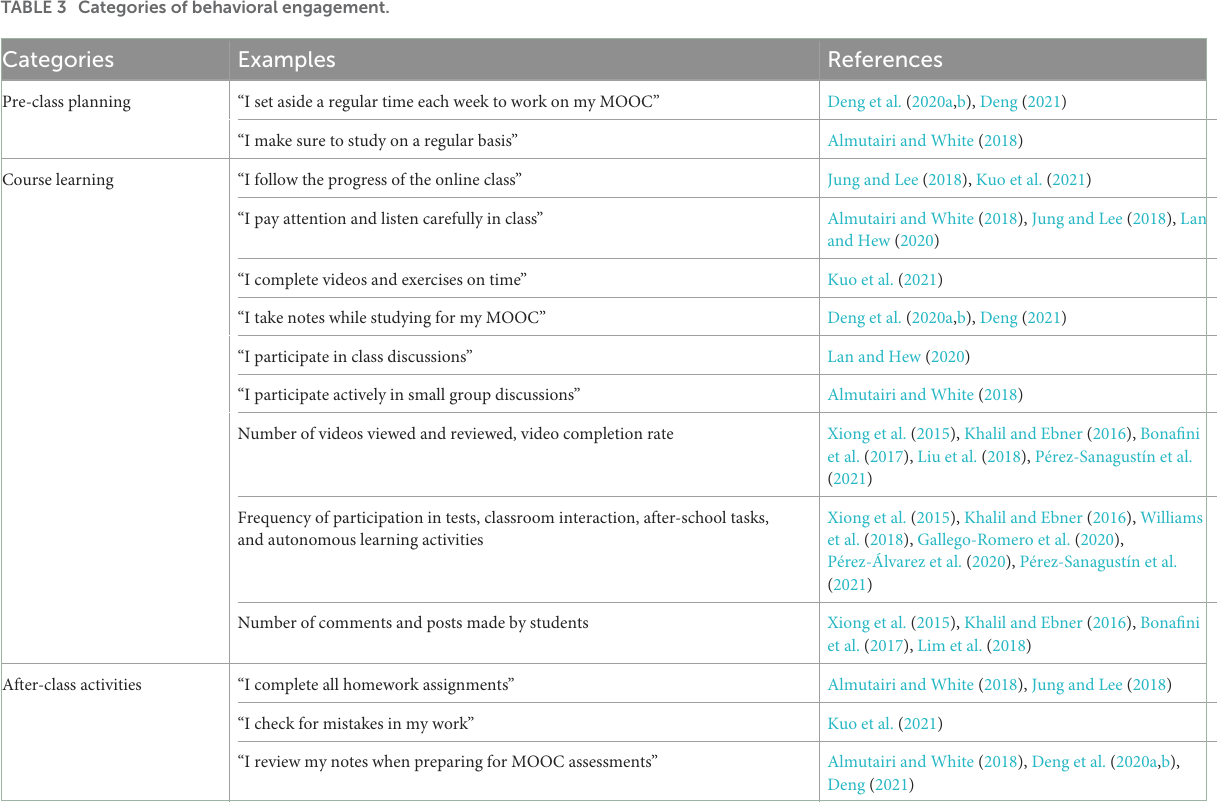
TABLE 3 Categories of behavioral